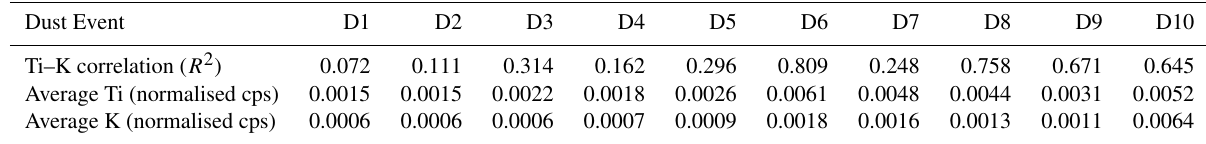
Table 2. Ti–K correlation ( R 2 ) alongside average cps for K and Ti for each of the dust events as identified within the Mohos core. Dust Event D1 D2 D3 D4 Ti–K correlation ( R 2 ) 0.072 Average Ti (normalised cps) 0.0015 Average K (normalised